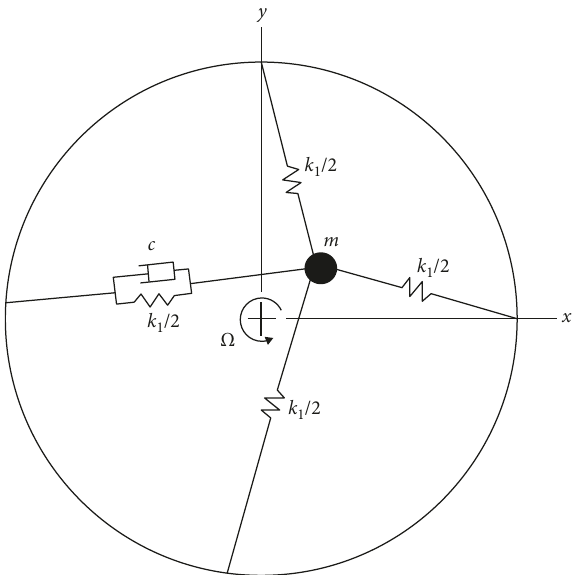
Figure 5: A two-degree-of-freedom gyroscopic